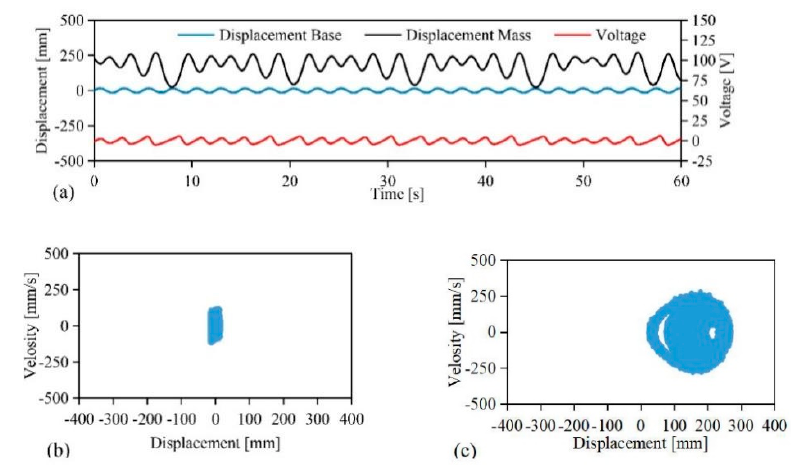
Figure 9. Measurement results of response vibration displacement and vibration power generation when vibrating with a period signal 0.4 Hz. ( a ) Results of response vibration displacement. ( b ) Diagram of displacement velocity of vibration of the support. ( c ) Diagram of displacement velocity of vibration of the mass block.